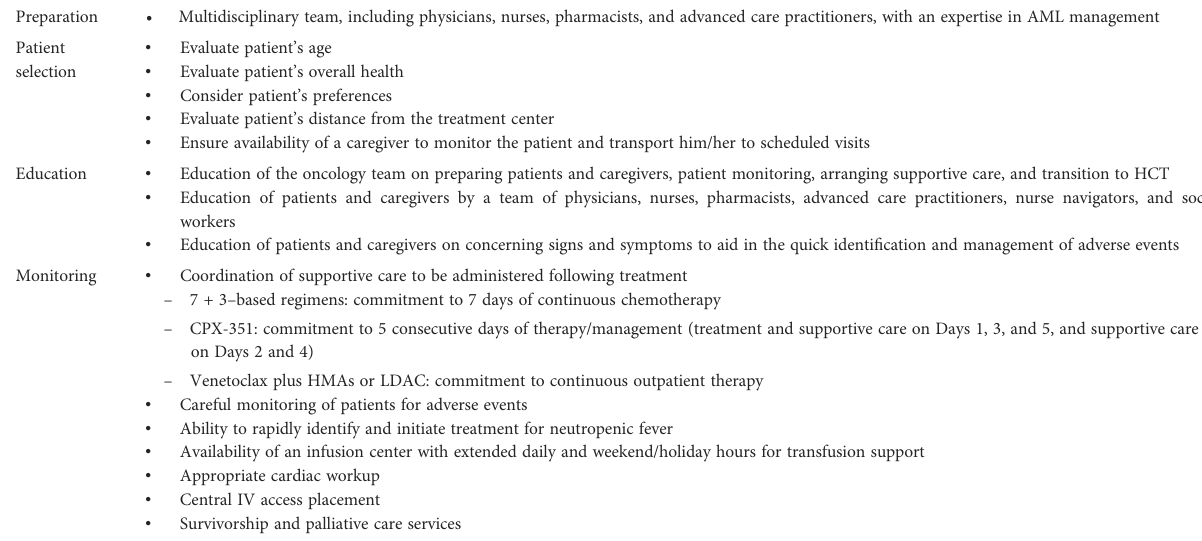
TABLE 2 Considerations for co-managing patients in the outpatient